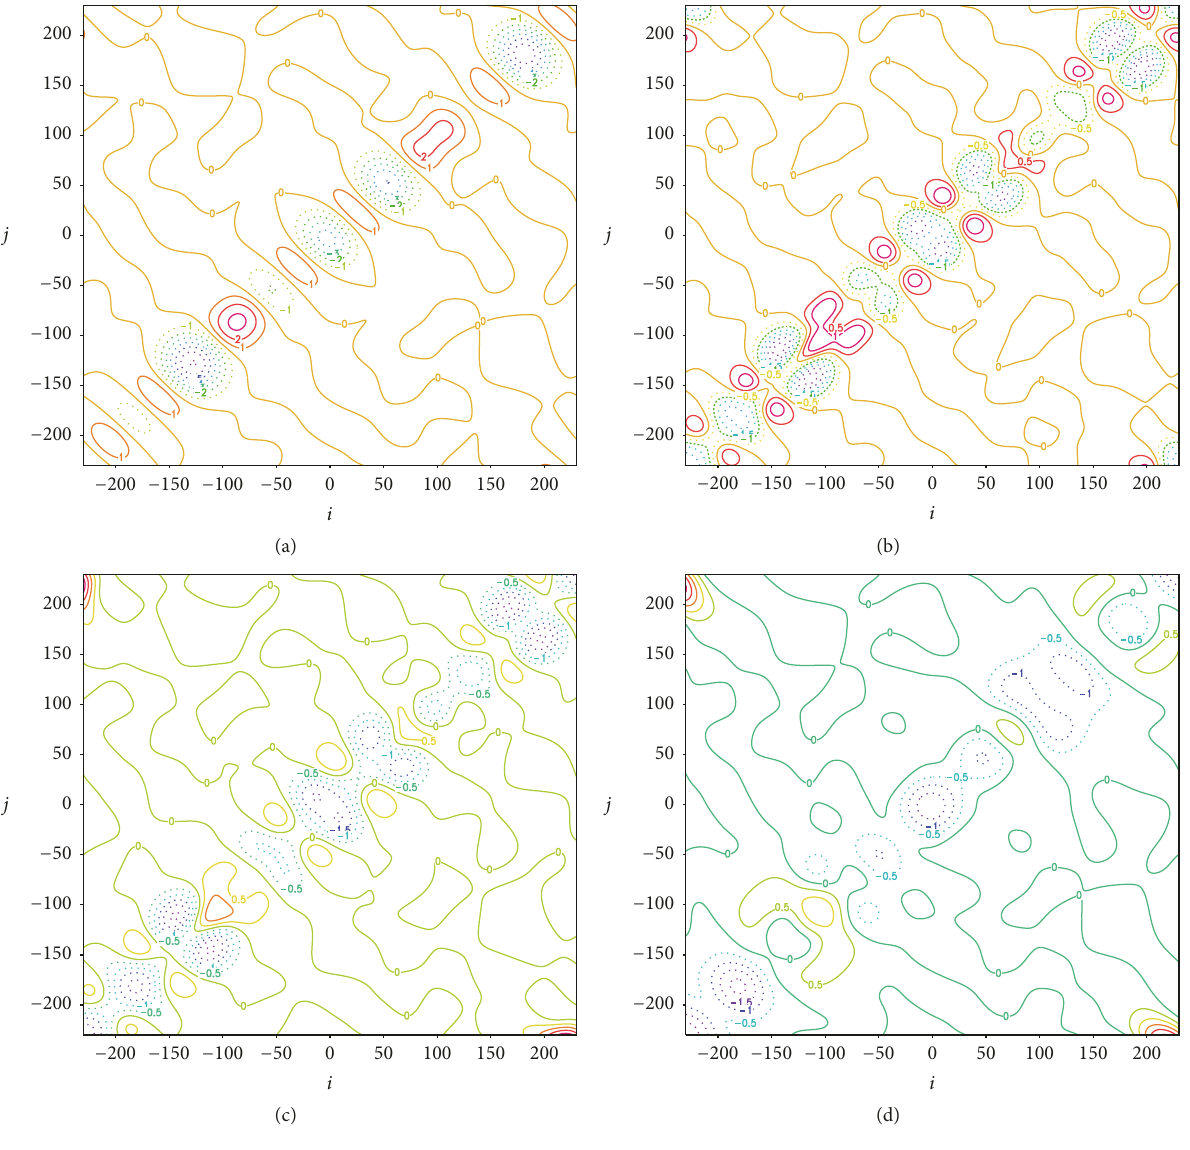
Figure 7: As in Figure 4 but for the case in Figure